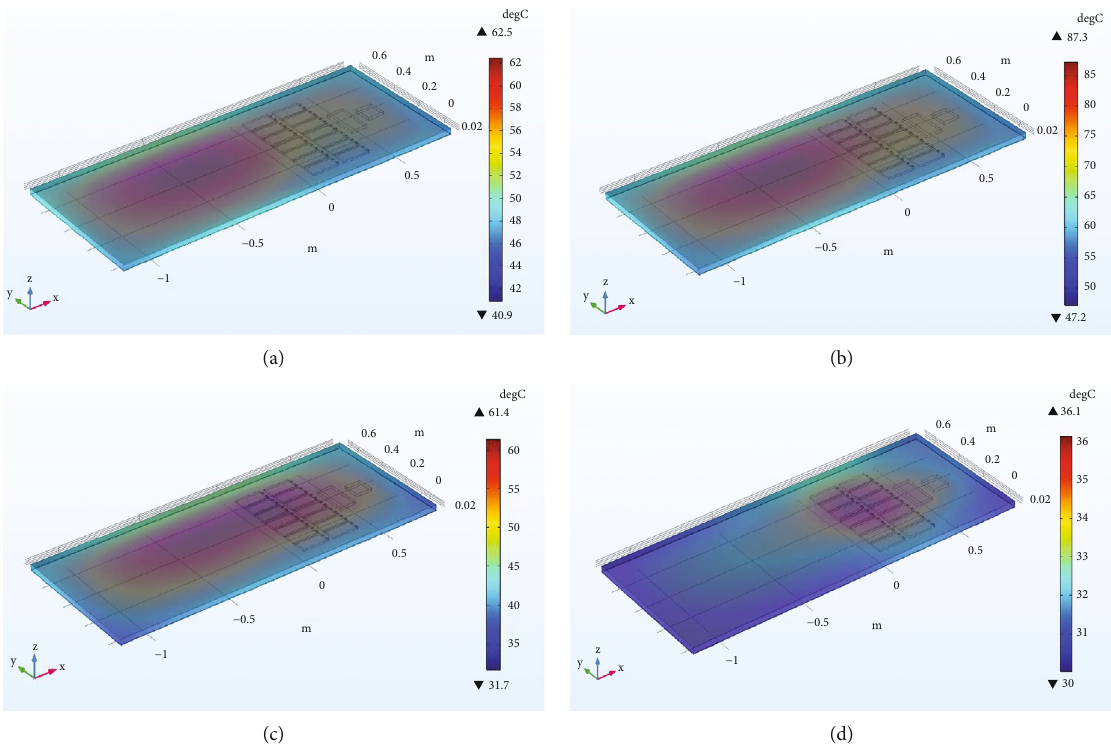
Figure 8: Temperature contours of G – PBIS under air convection mode: (a) 15000s, (b) 25000 s, (c) 35000s, and (d) 45000